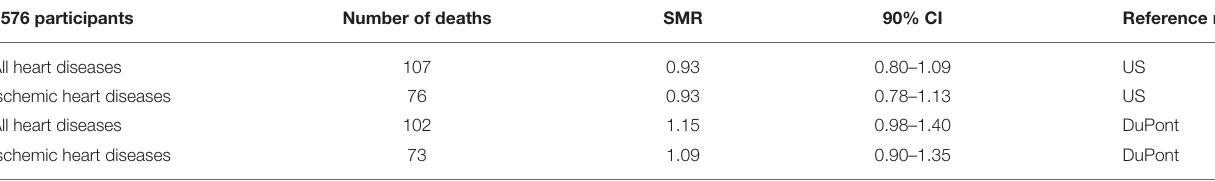
TABLE 6 | US cohort mortality study of DuPont TiO 2 production workers (17).